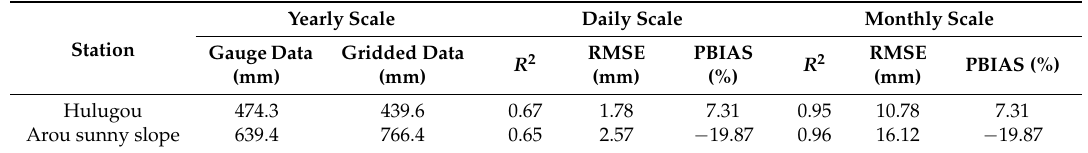
Table 1. Simulated evaluation of temperature, specific humidity, and wind speed.